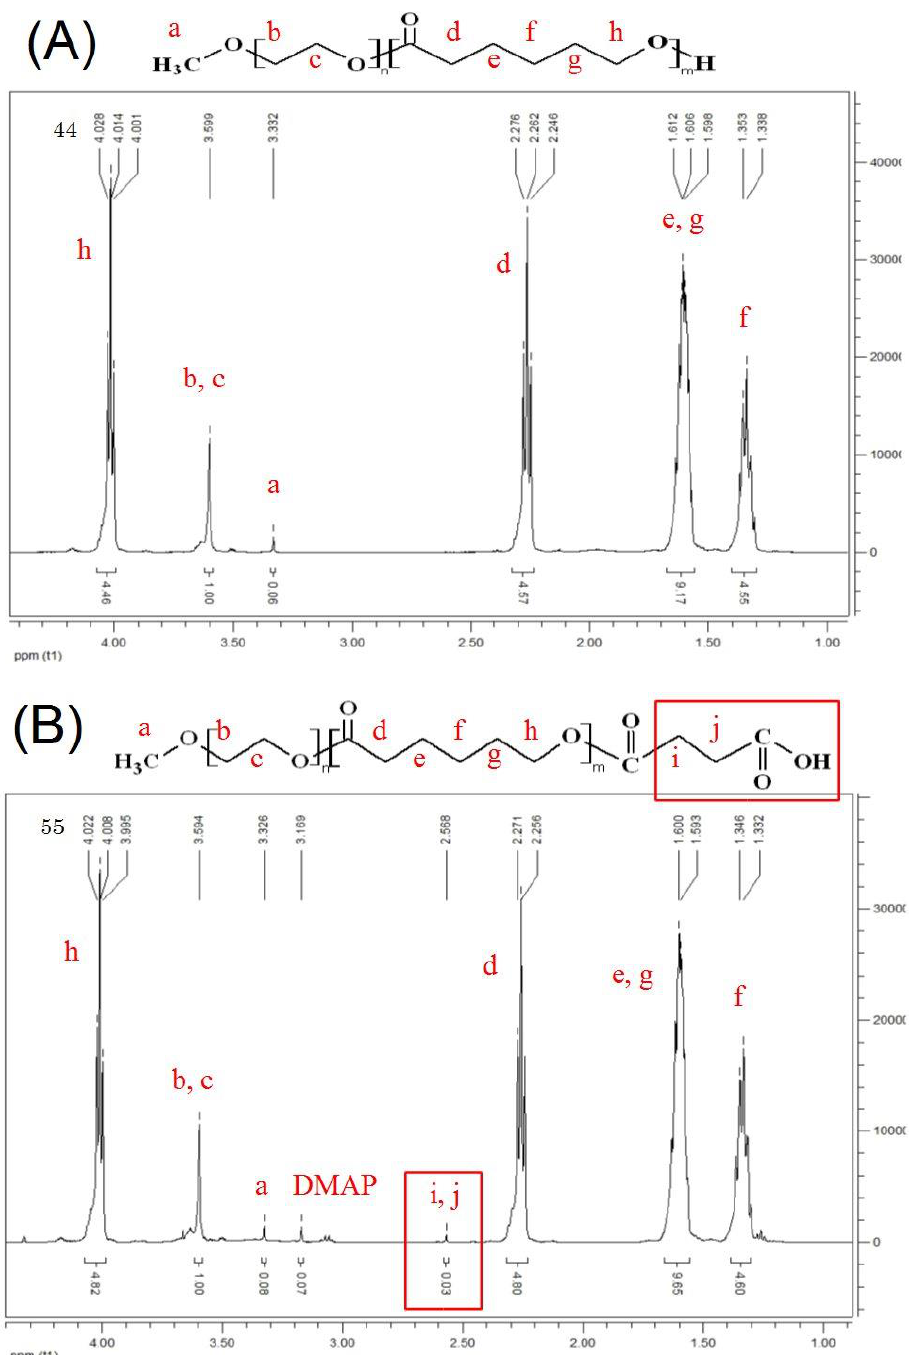
Figure 5. 1 H NMR spectrum of ( A ) mPEG-PCL and ( B ) mPEG-PCL-COOH.